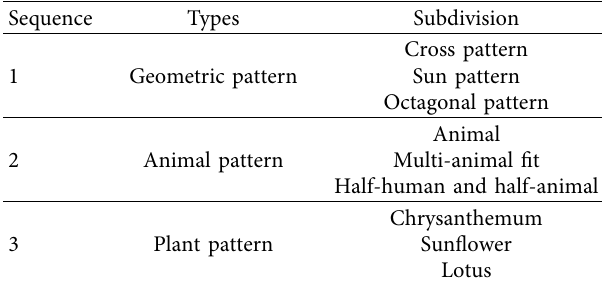
Table 2: Classification of decorative patterns of ethnic